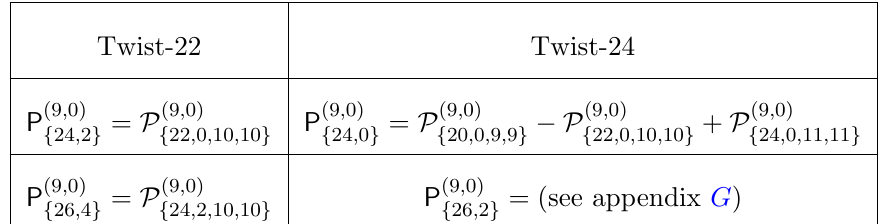
Table 5 . Decomposition of sum rules P (9 ; 0) into super-sum rules Twist-22 Twist-24